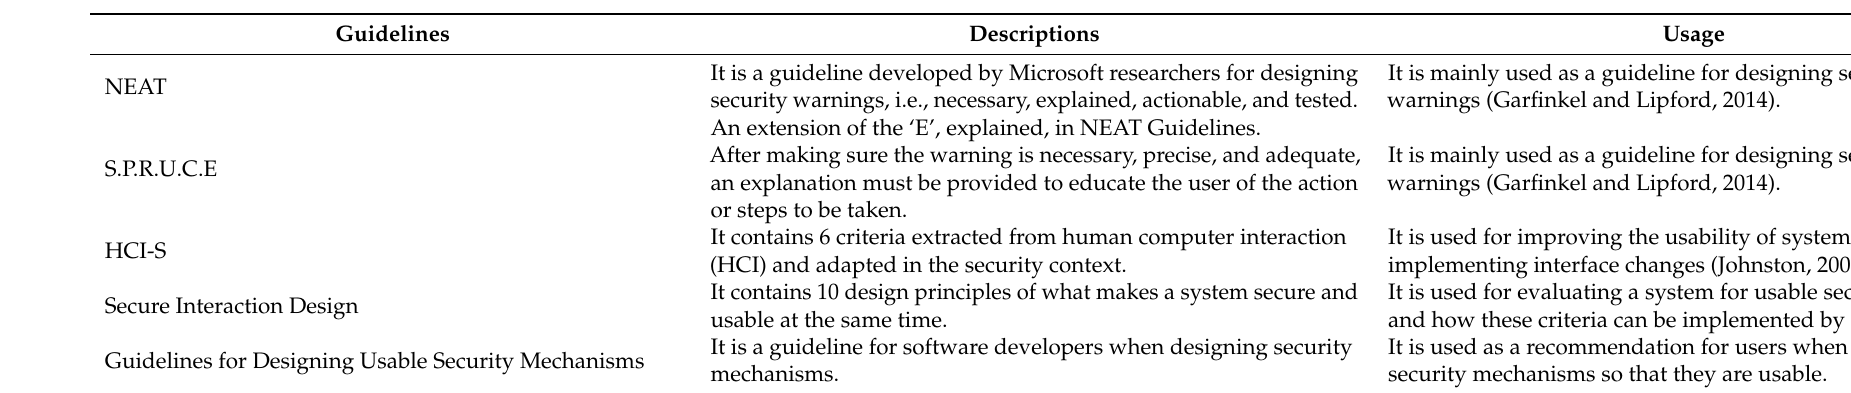
Table A3. Guidelines for warning